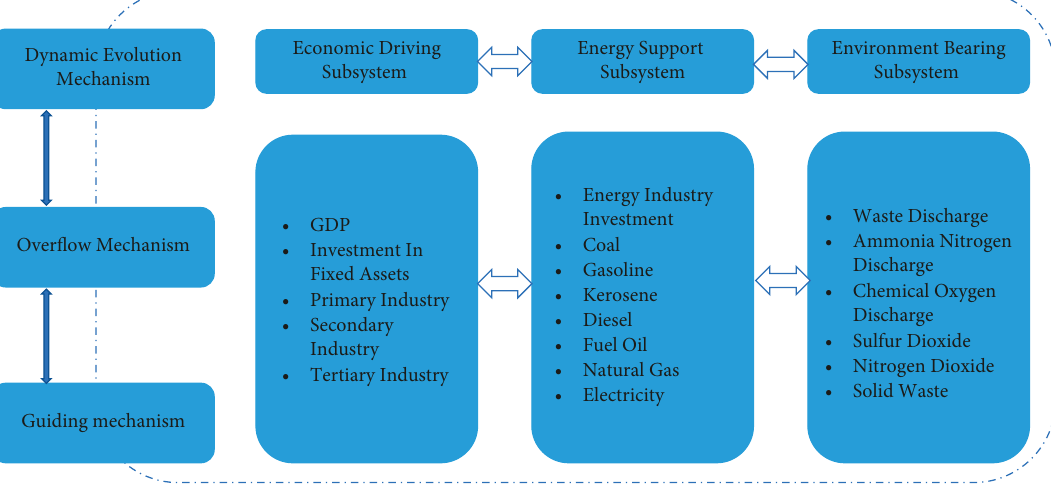
Figure 1: The EEE complex system and